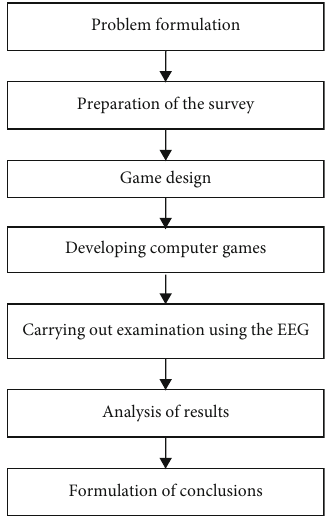
Figure 2: Proposal for a test